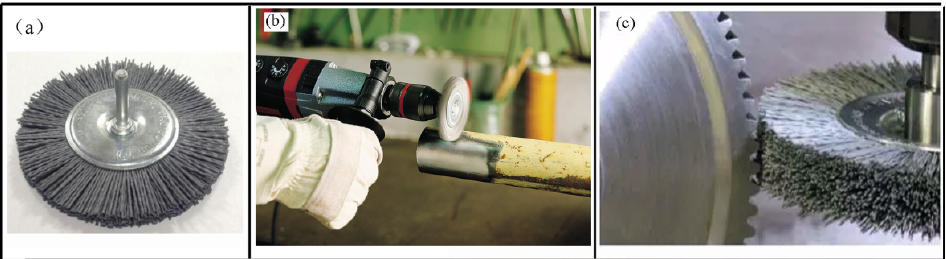
Figure 1. Abrasive filament brush ( a ); brush derusting ( b ); and grinding gear ( c ).